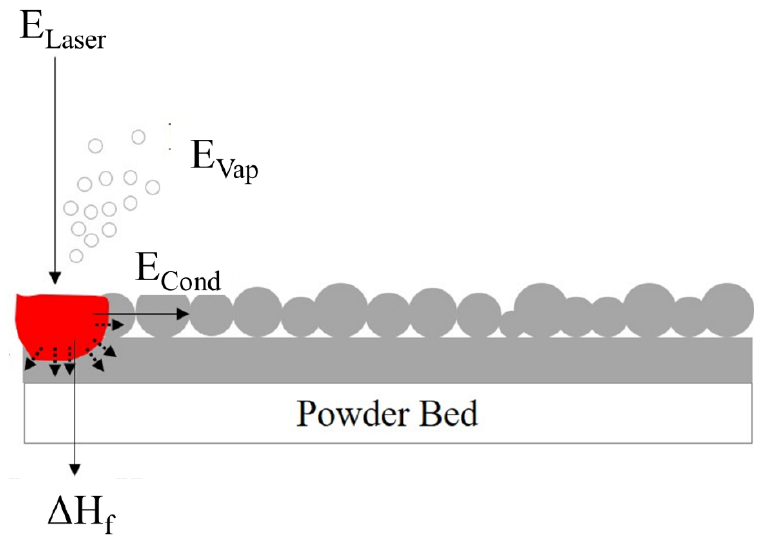
Figure 5. Schematic diagram of SLM process.